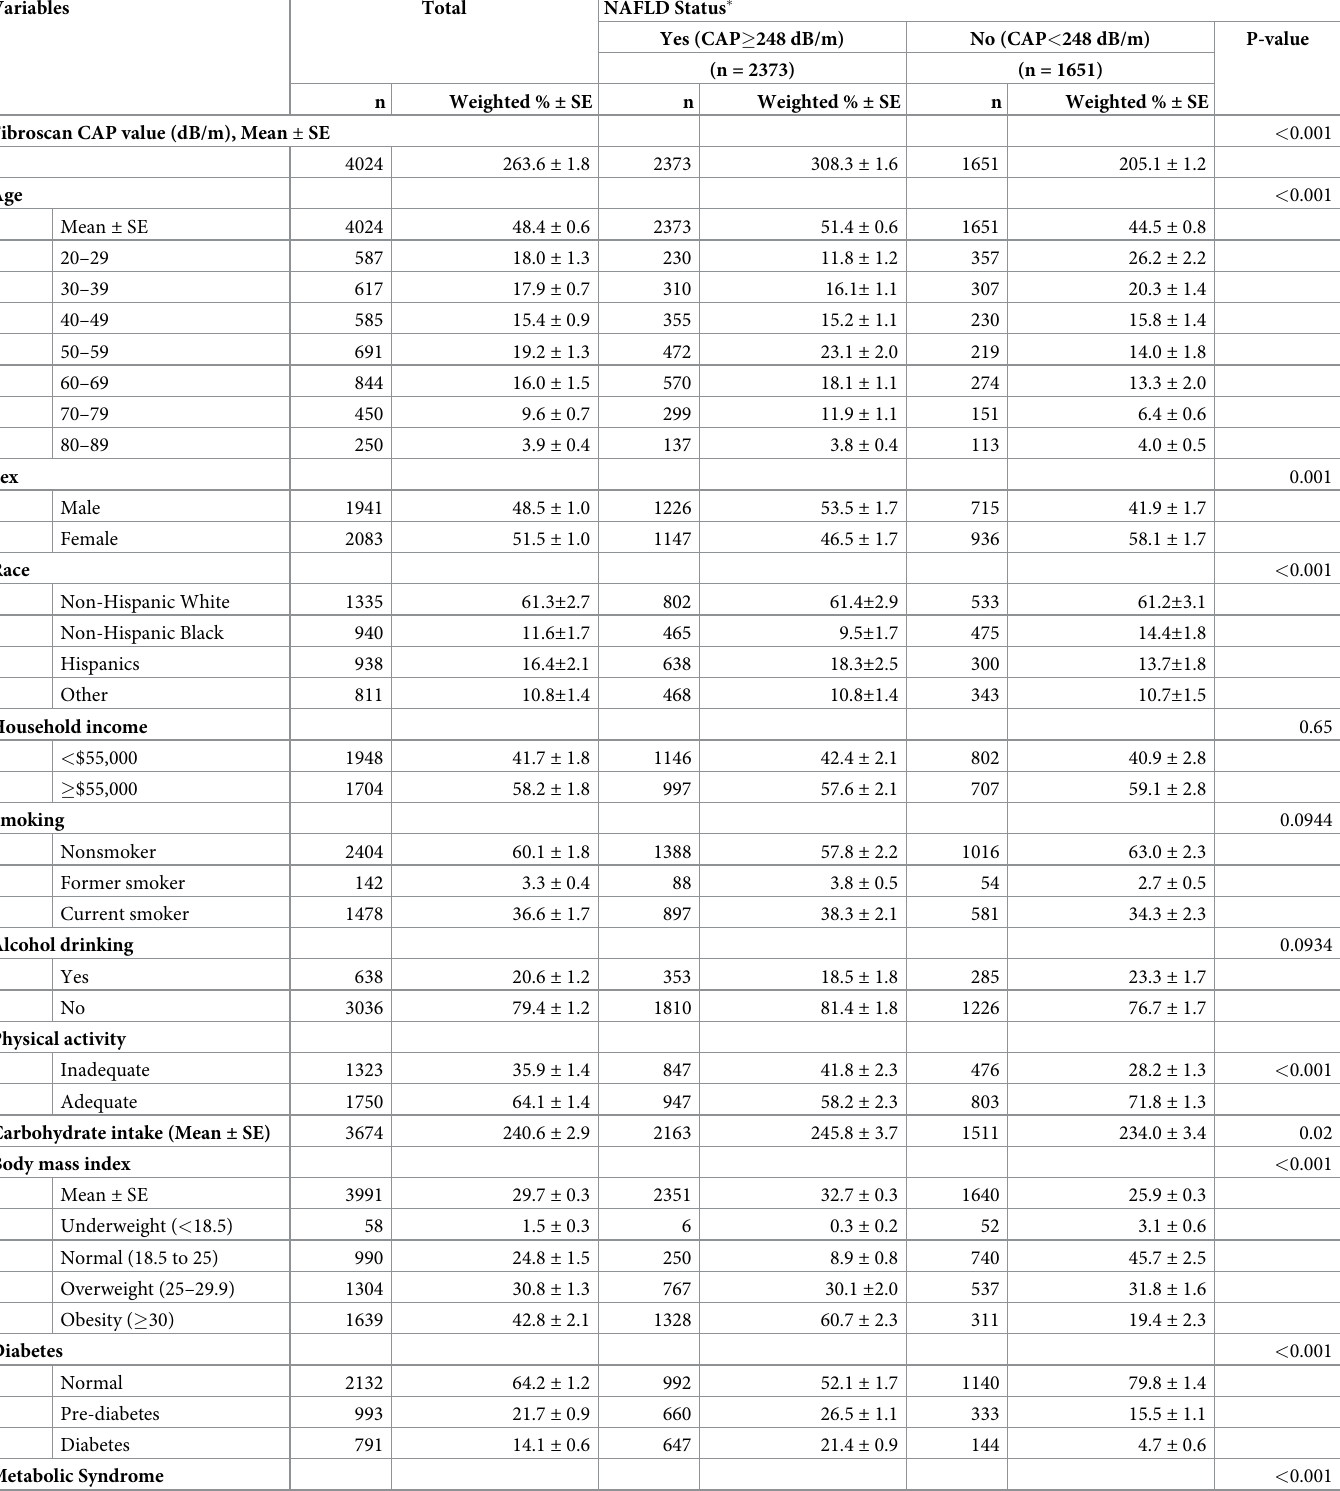
Table 1. Characteristics of factors according to NAFLD status by